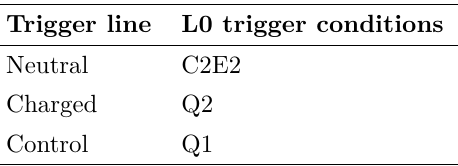
Table 3. Beam-dump trigger lines and the corresponding L0 trigger conditions. No L1 conditions are applied in beam-dump